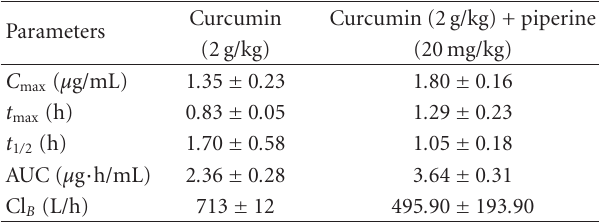
Table 4: Nutraceuticals bioenhanced by piperine [13, 19]. Table 5: Comparative pharmacokinetic parameters after oral supplementation of curcumin and curcumin + piperine in human volunteers